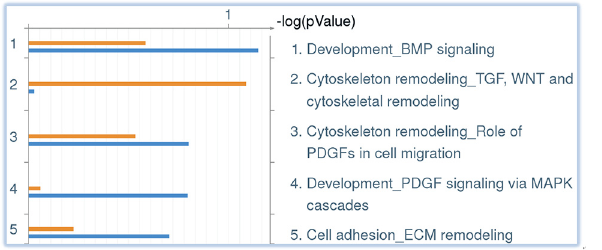
Fig 2. The top five pathways involved in “ tissue remodeling and wound repair ” via MetaCore analyses. The orange bar stands for significant genes ( P < 0.05) acquired from microarray data, while the blue bar is the expected gene directly interacting with miR-196 from TargetScan. The list of possible affected pathways is arranged as per descending P value score.